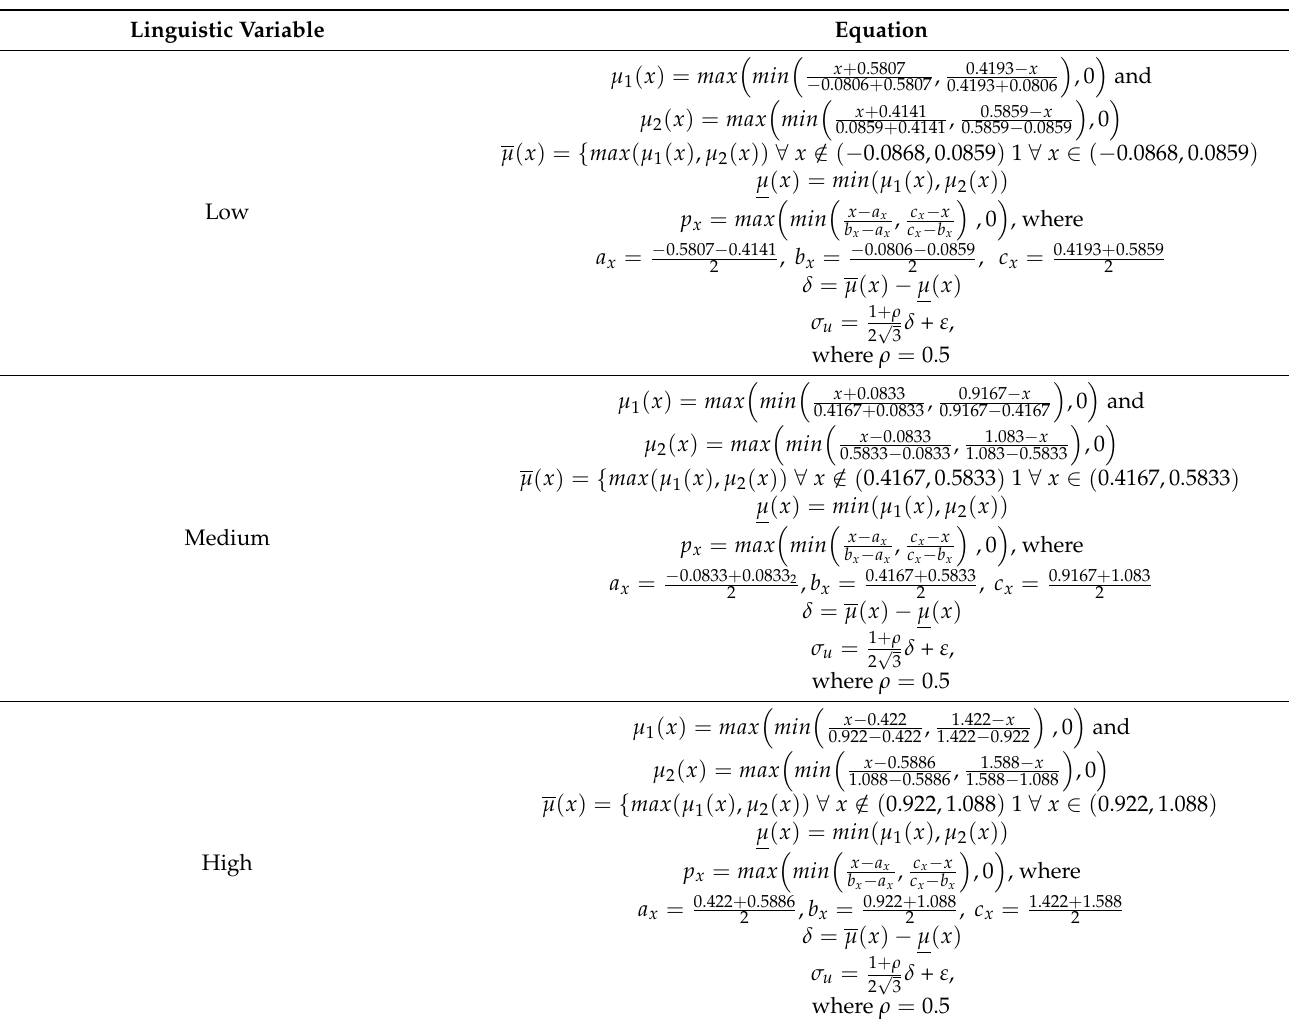
Table 1. GT2MFs for the antecedent and consequent variables.